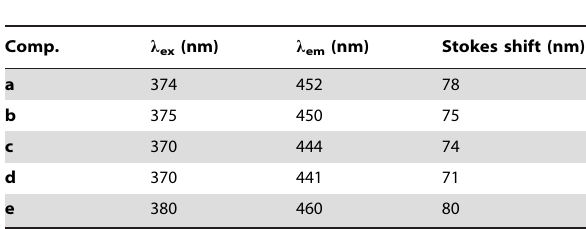
Table 8. Florescence spectra of a–e in ethanol.